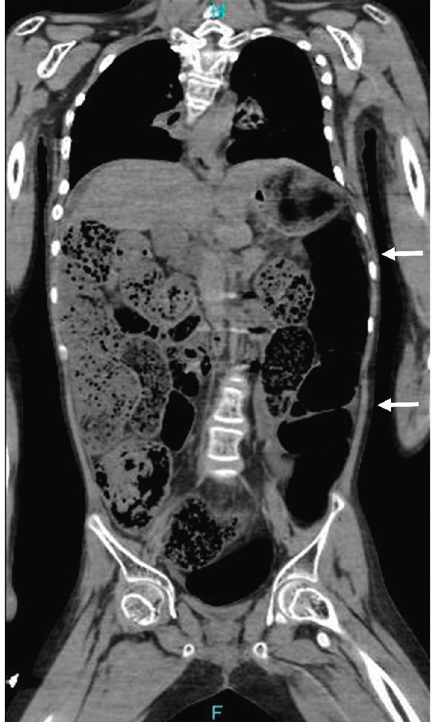
Figure 1: Abdominal computed tomographic image. The arrows show the patient’s dilated and thinned intestines from the duo- denum to the sigmoid